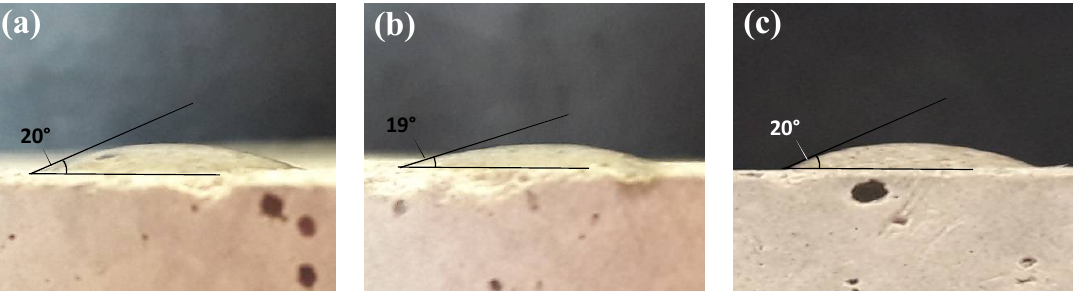
Figure 5. Contact angles for water/air/rock systems ( a ) before, and after contact with dispersions of 10,000 mg/L of ( b ) NCS20, and ( c ) NCP50 materials in deionized water at a fixed temperature of 25 °C.